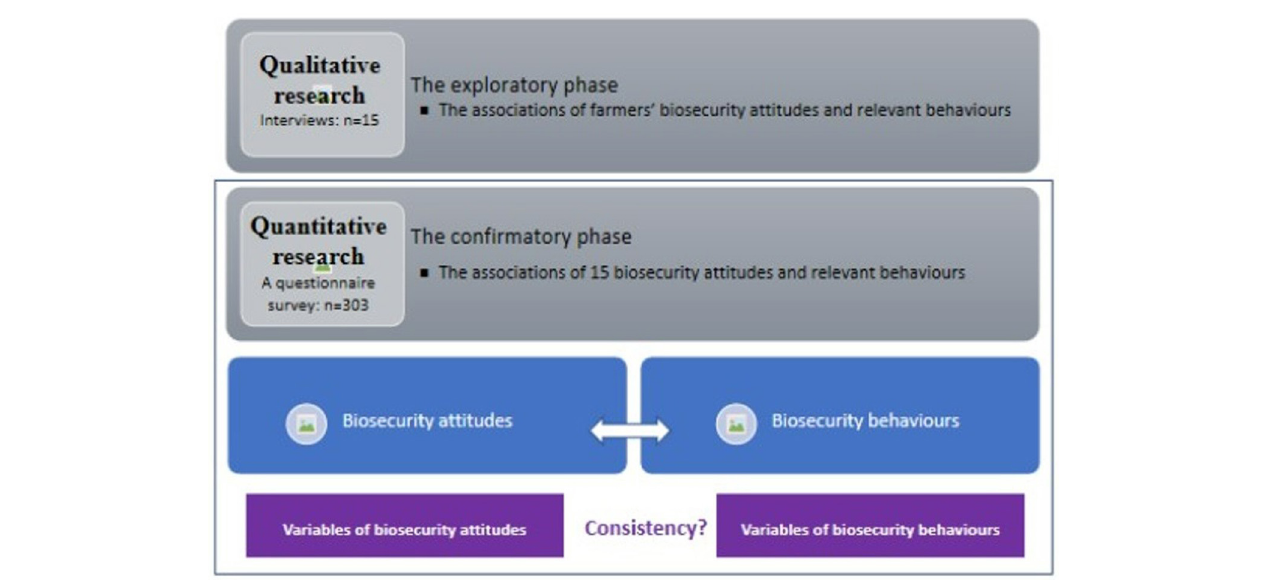
FIGURE2 The framework and the relationships of variables used in the study. The study involved two consecutive phases: qualitative research followed by quantitative research. The qualitative phase served as exploratory research so that the relationships of farmers’ biosecurity attitudes and behaviours could be examined to inform the subsequent quantitative